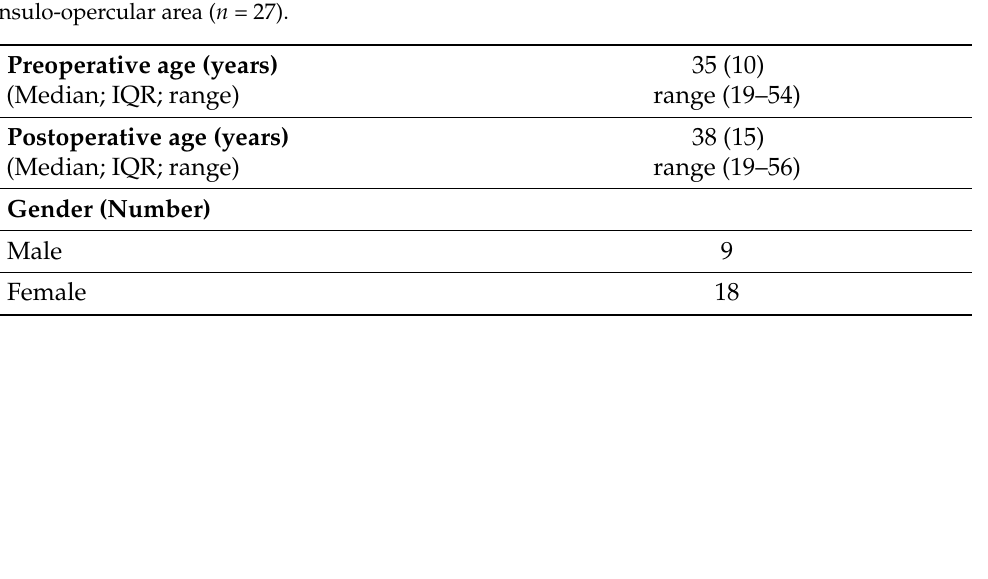
Table 3. Demographic and clinical features of patients whose epileptogenic zones involved